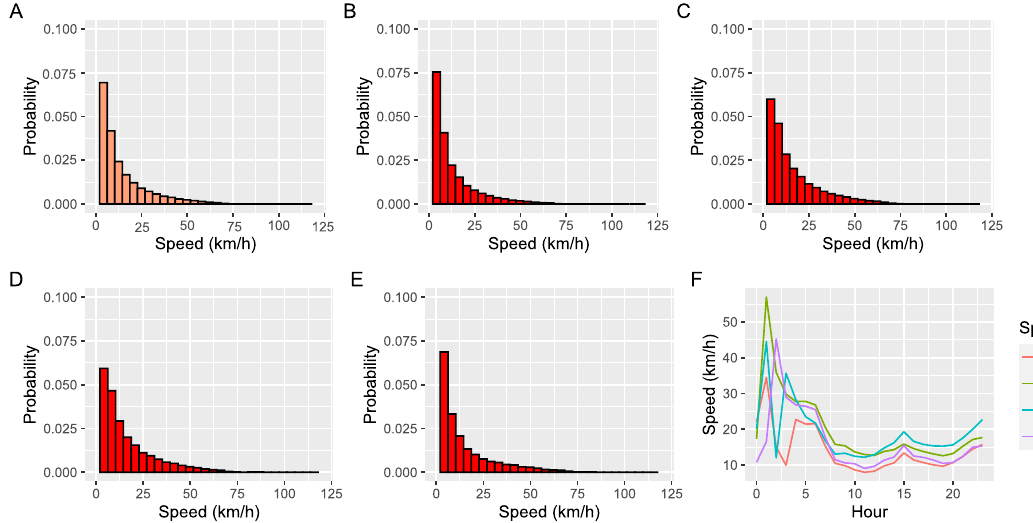
Figure 7. Speed distance distribution and trip speeds by time of day for HH, NH, HN, and NN